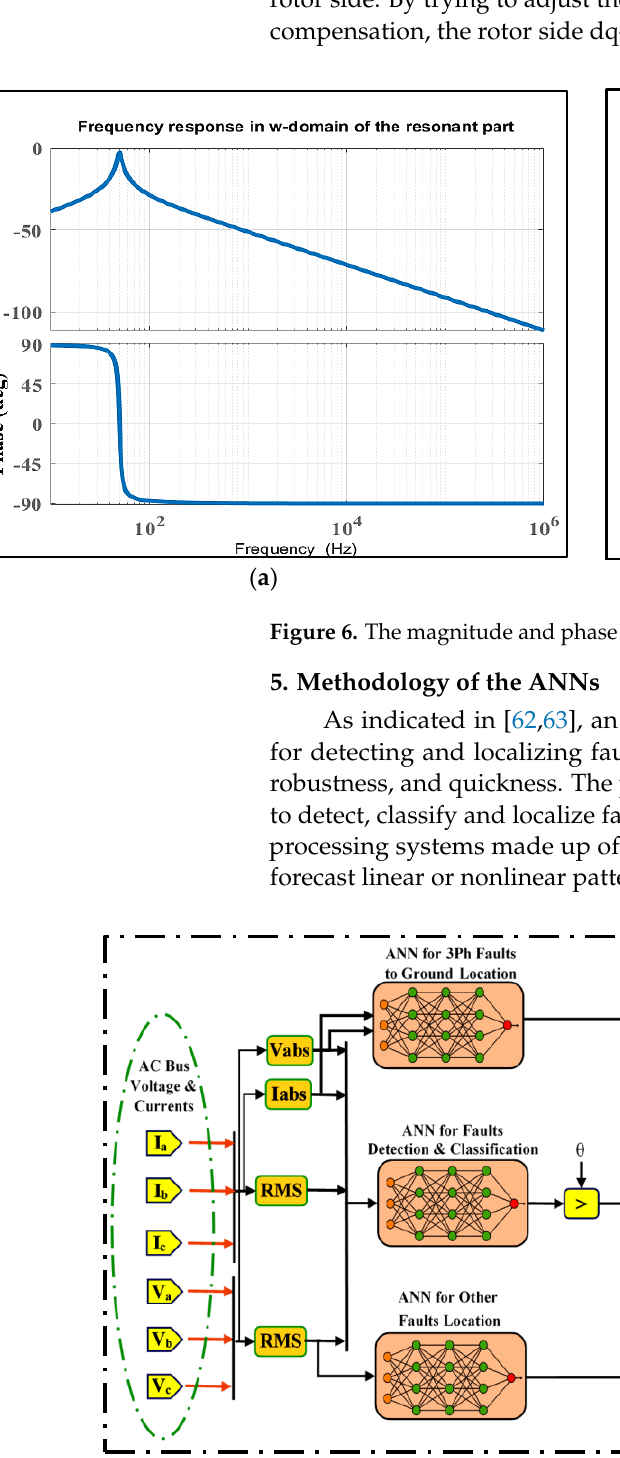
Figure 7. ANN-based schematic representation for fault detection, classification, and location.